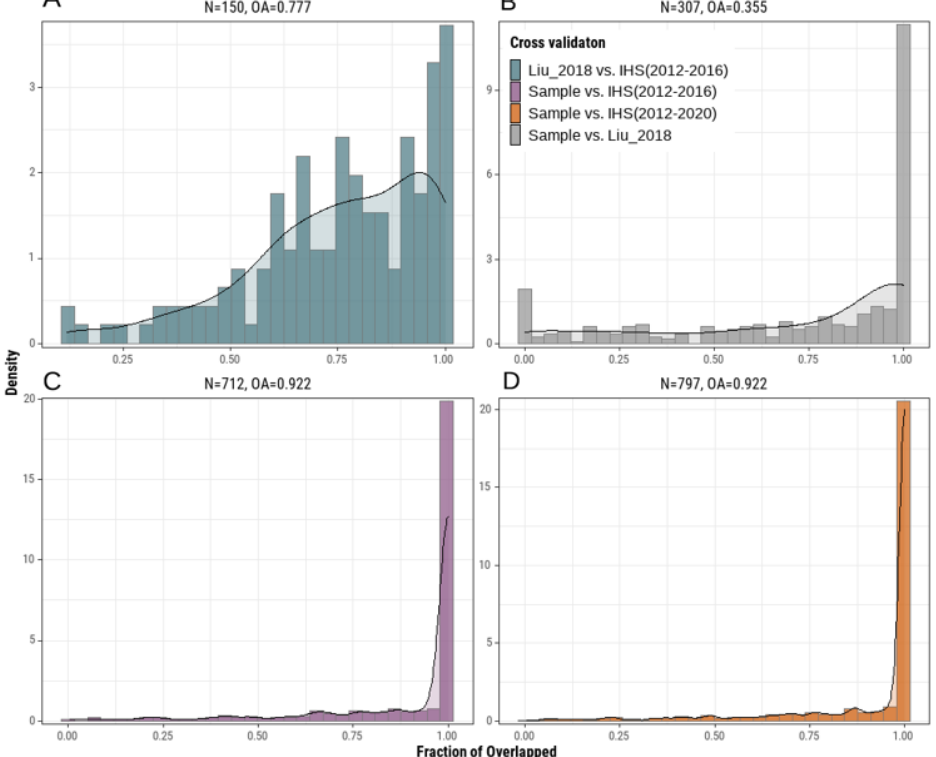
Figure 6. The density histogram shows the patch-level rate of the overlapping area (ROA) that was cross-validated between the Liu_2018 data and the IHS pixels of 2012–2016 ( A ), the sample data and the Liu_2018 data ( B ), the sample data and the IHS pixels of 2012–2016 ( C ), the sample data and the IHS pixels of 2012–2020 ( D ). N represents the number of overlapping reference IHS patches; OA represents the overall accuracy in terms of the fraction of validated patches from the reference data.